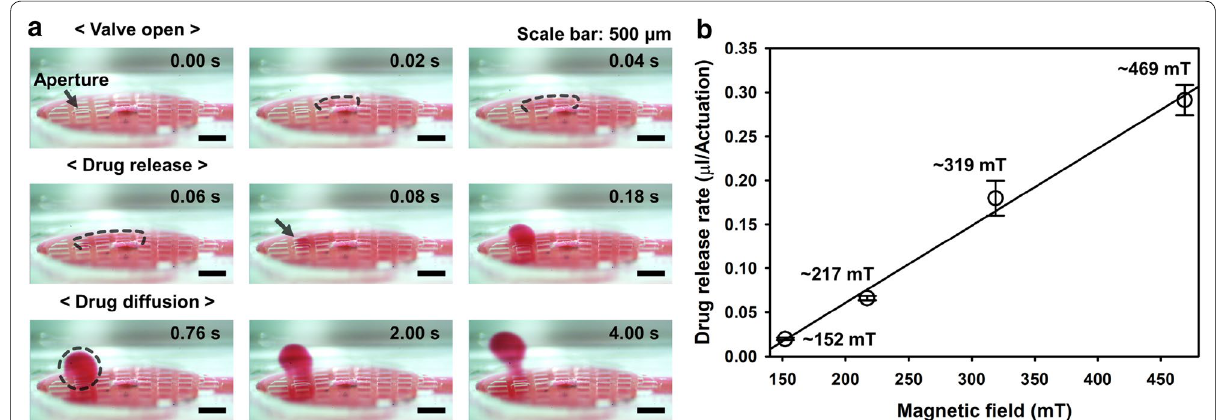
Fig. 3 a The sequential images show the drug release process of the proposed magnetic micropump with a short exposure (less than 1 s) of magnetic field (469 mT), including the valve opening, the drug release, and the drug diffusion. b The quantitative evaluation of the drug release according to the strength of the magnetic field from 152 to 469 mT. Error bars indicate the standard deviation (n